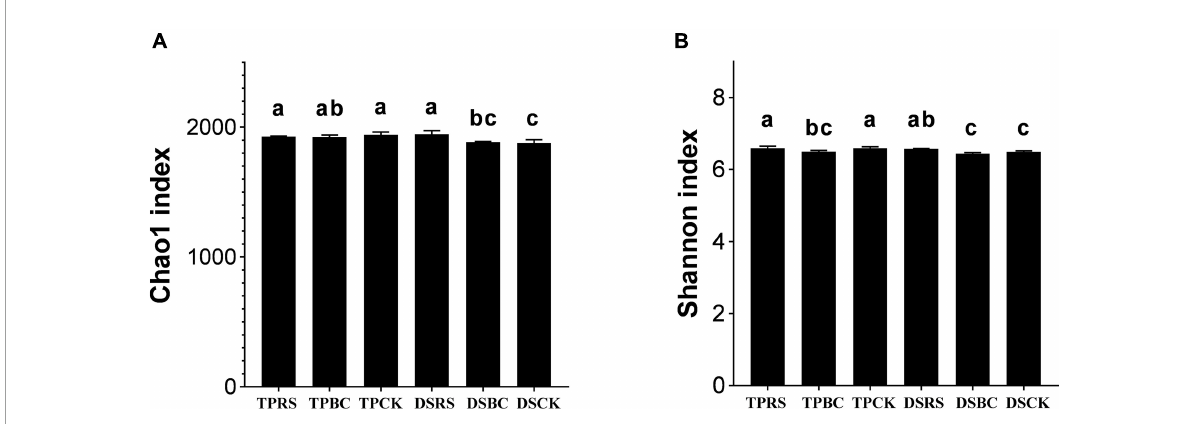
FIGURE1 The diversity and richness of bacterial communities in the rhizosphere soil samples subjected to the planting methods and organic amendments characterized by the Chao (A) and Shannon indexes (B) (alpha diversity). Different letters indicate statistical significance at the P < 5% level within planting methods and organic amendments. TP, transplanting; DS, direct seeding; RS, rice straw; BC, biochar; CK, no RS or